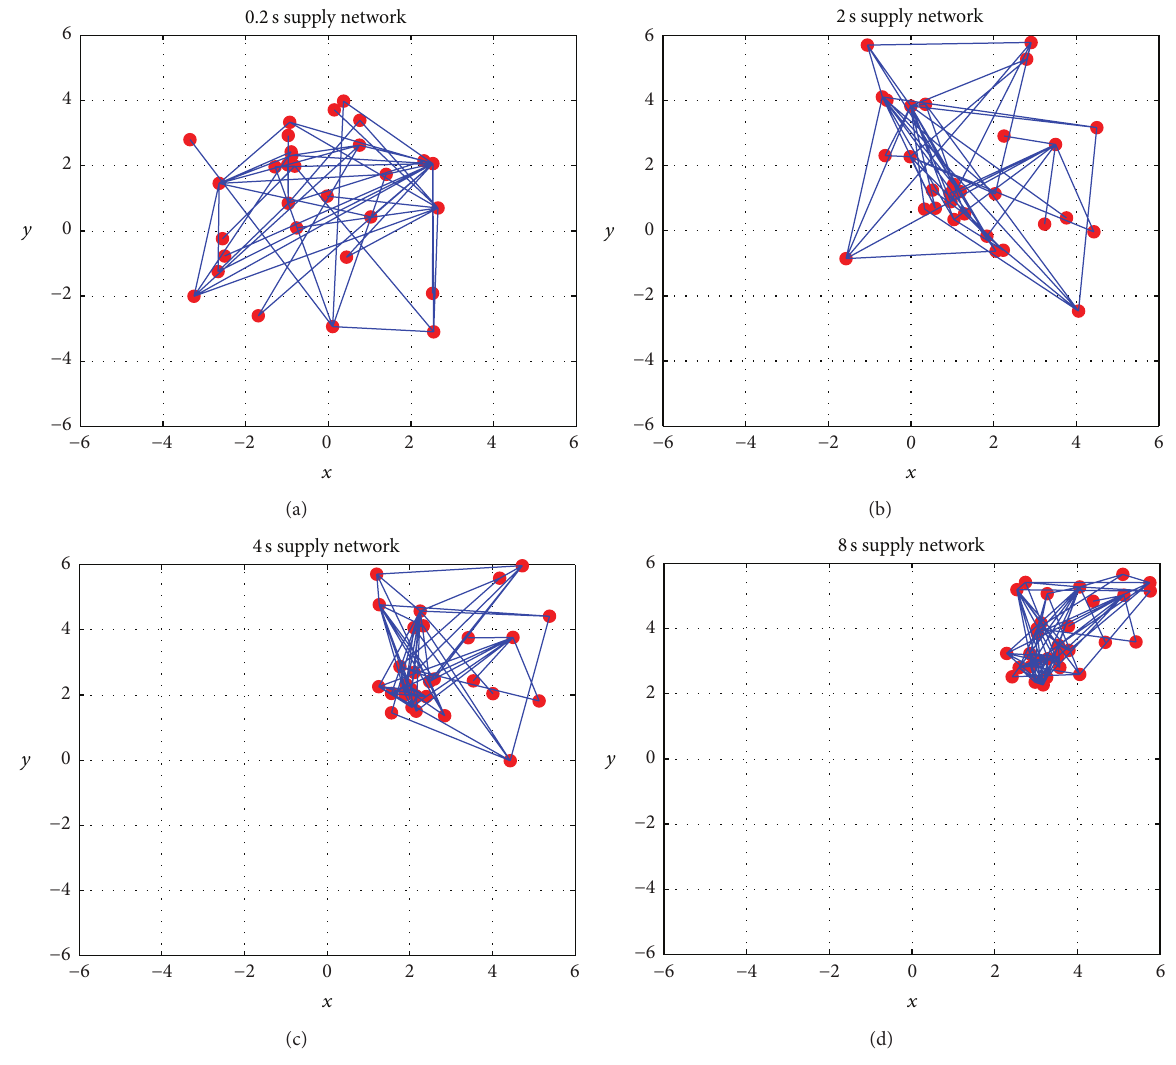
Figure 4: The emergence of supply chain combined